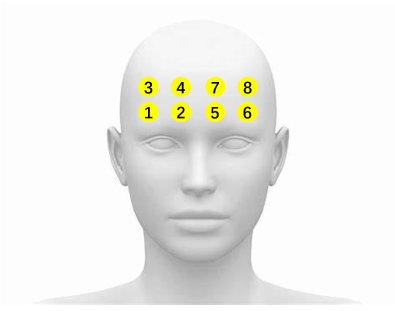
Figure 4. Channel order of fNIRS.